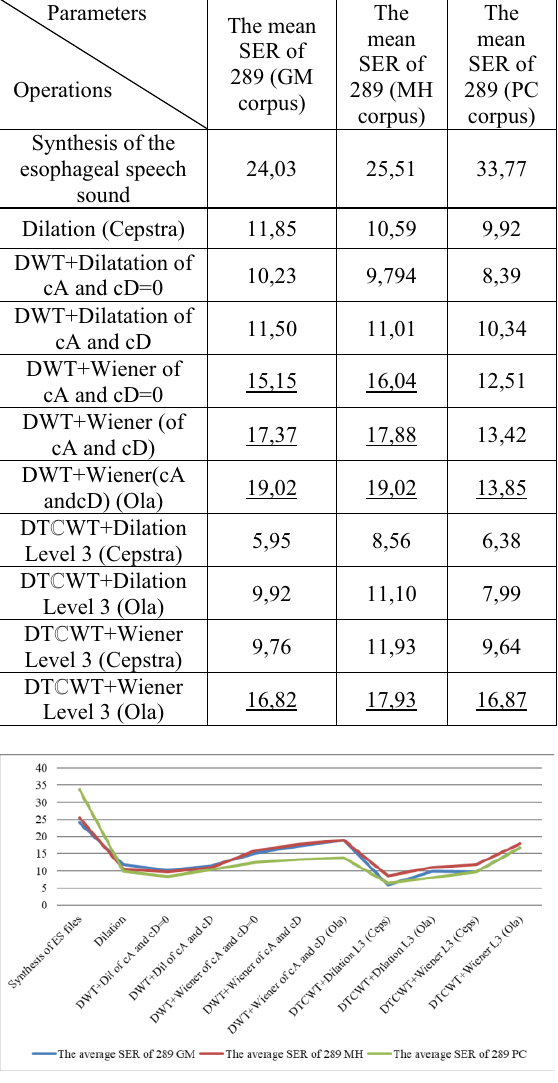
Table 2. The average of the SER of the operations performed on the three corpora, for the two hybrid methods Parameters